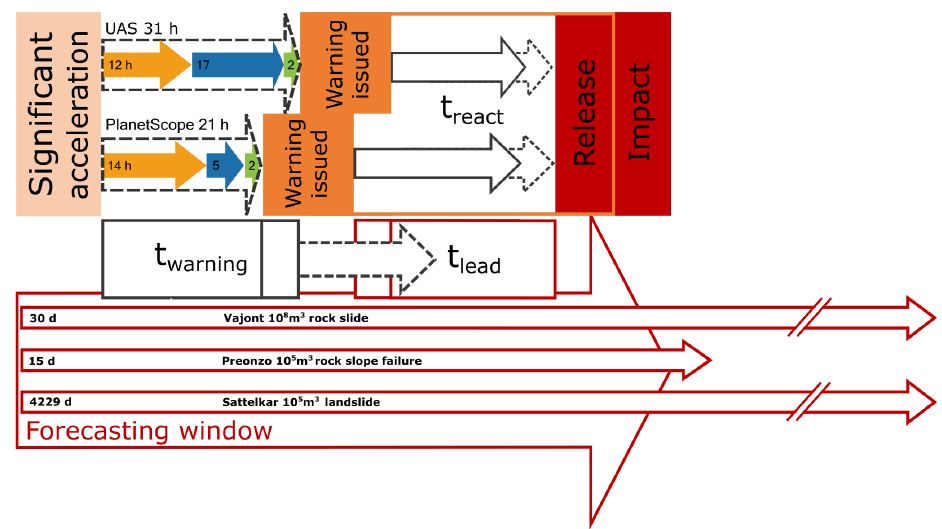
Figure 8. Conceptual approach with estimated t warning for the UAS and PlanetScope. Phases of collection, processing and evaluation (indi- cated as arrows of relative length in orange, blue and green, respectively) (see phases in Figs. 1 and 7) with their total duration time (dashed grey arrows). In t warning , one additional observation requires in sum 31h for UAS and 21h for PlanetScope data. Above, major landslides are compared from the onset or displacement detection (solid line) (Petley and Petley, 2006; Anker et al., 2016; Sättele et al.,